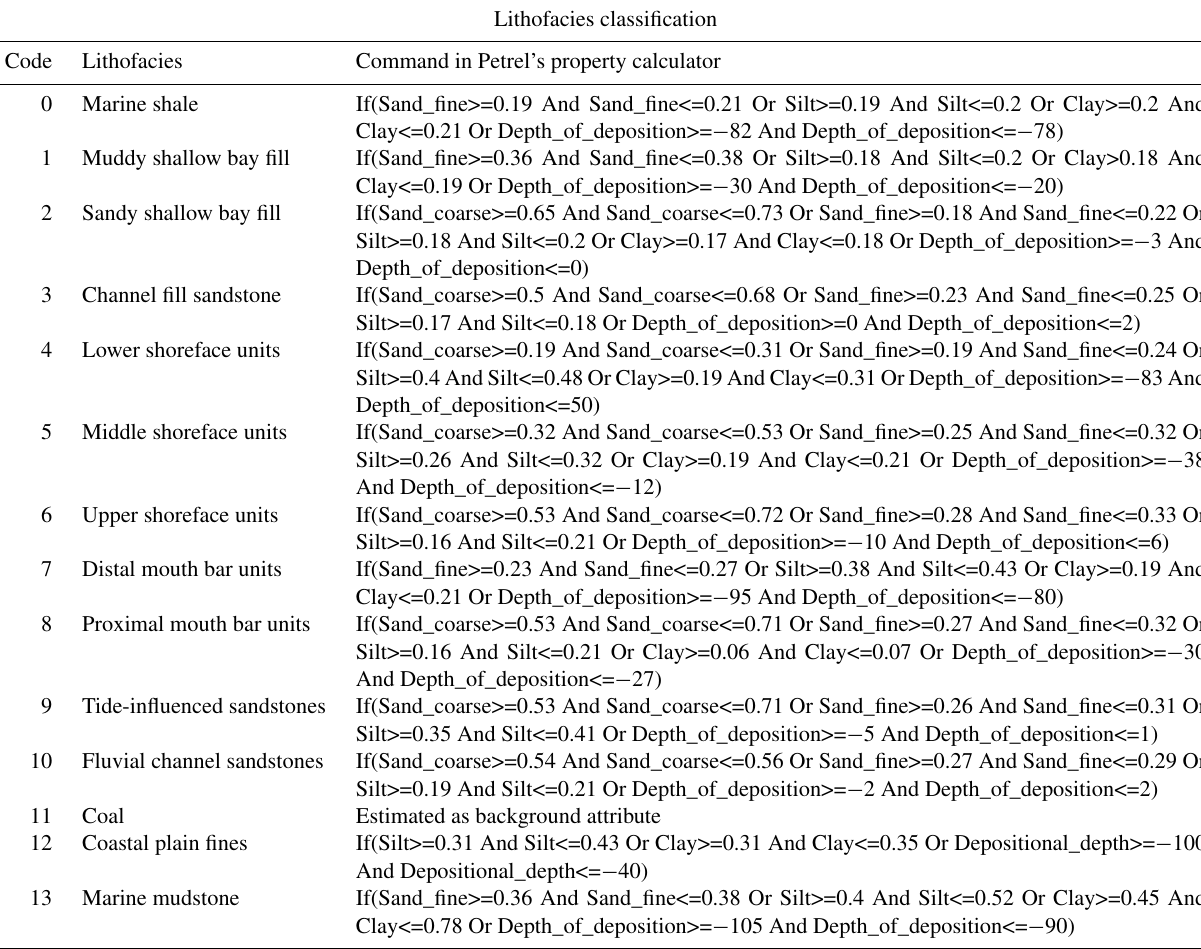
Table 3. Lithofacies classification in the forward stratigraphic model by using the property calculator tool in Petrel™. Lithofacies